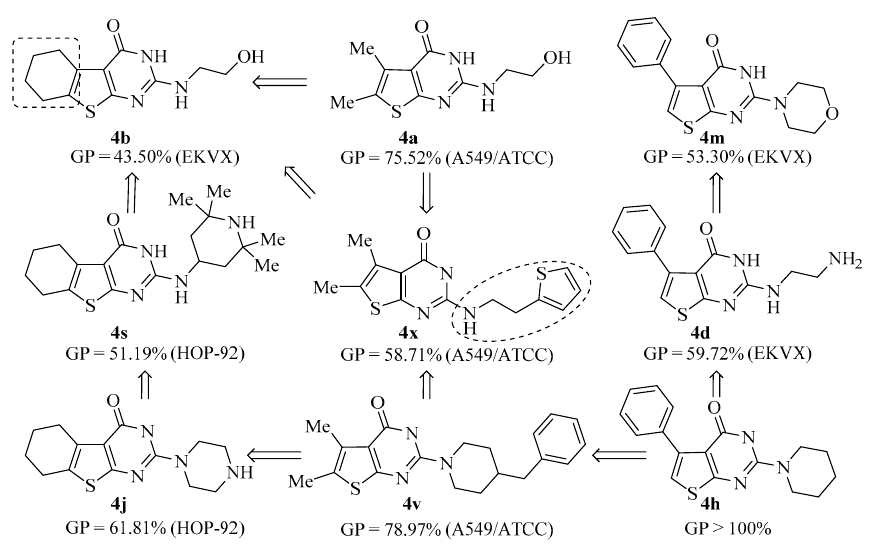
Figure 5. Structure–activity relationship among thieno[2,3- d ]pyrimidines based on GP (Growth Percent) towards non-small cell lung cancer cell lines.